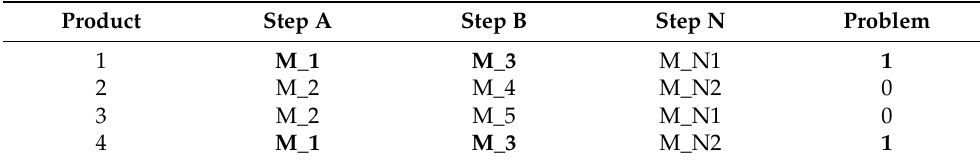
Table 1. Data generated by the example depicted in Figure 1, in tabular